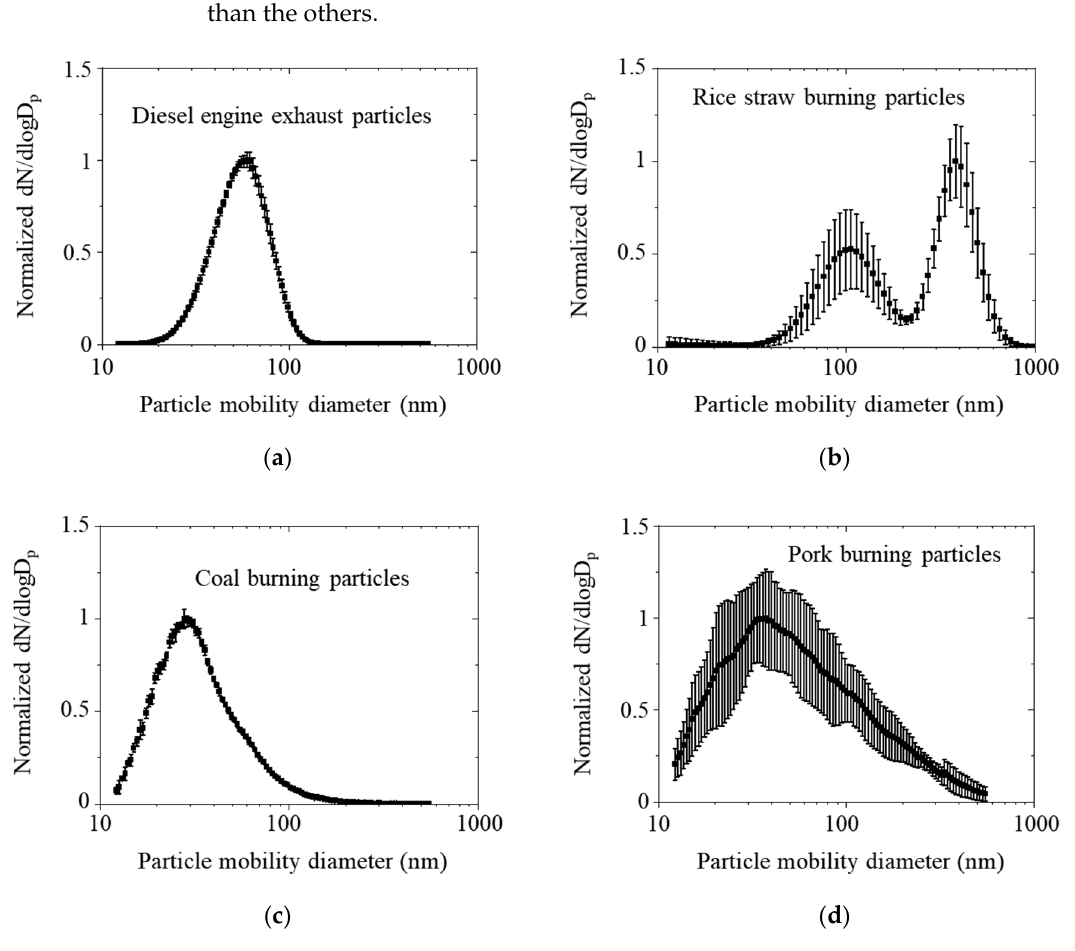
Figure 5. Particle number size distributions for various combustion aerosols (( a ) diesel engine, ( b ) rice straw burning, ( c ) coal burning, and ( d ) pork burning).